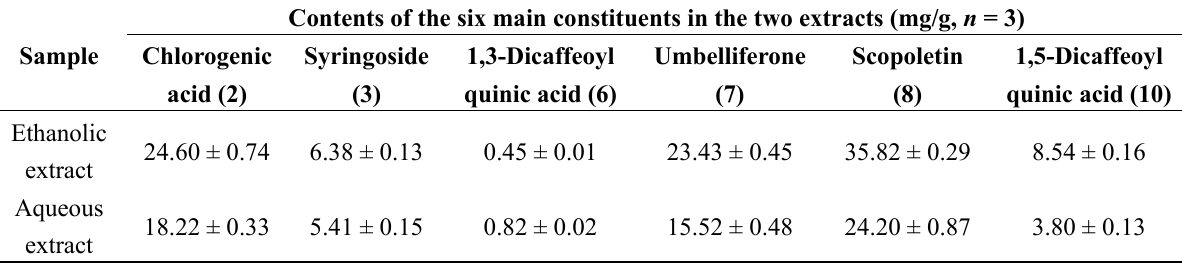
Table 1. The contents of six constituents in the two SL extracts.